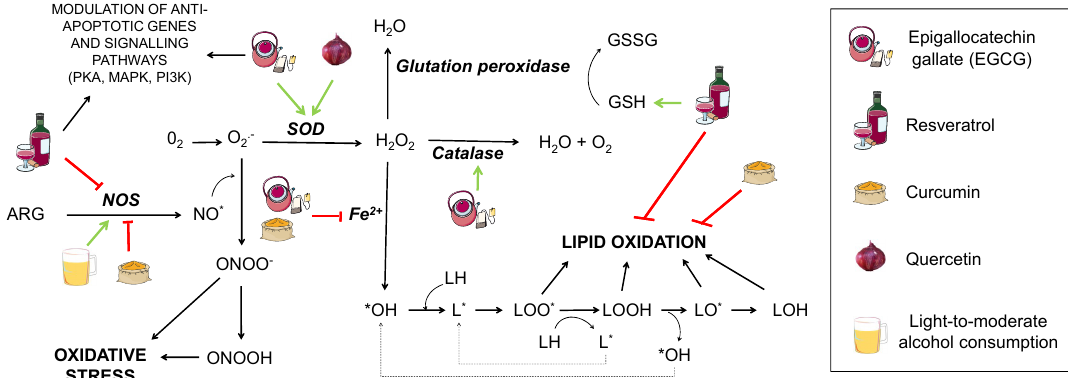
Figure 2. Effect of different nutrients on oxidative stress generation. Several pathways contributing to oxidative stress are shown interconnected. ARG: arginine. NOS: nitric oxide synthase. SOD: superoxide dismutase. NO*: nitric oxide. ONOO − : peroxynitrite anion. ONOOH: nitric acid. O 2 − : superoxide. H 2 O 2 : hydrogen peroxide. GSH: reduced glutation. GSSG: oxidised glutation. *OH: hydroxyl radical. LH: lipid. LOH: lipid alcohol. L*: lipid radical. LOO*: radical peroxidised lipid. LOOH: peroxidised lipid. LO*: alkoxyl. Nutrients that are proposed to interfere with the mentioned oxidative stress pathways are shown in the legend. Green arrows represent activation. Red truncated arrows show